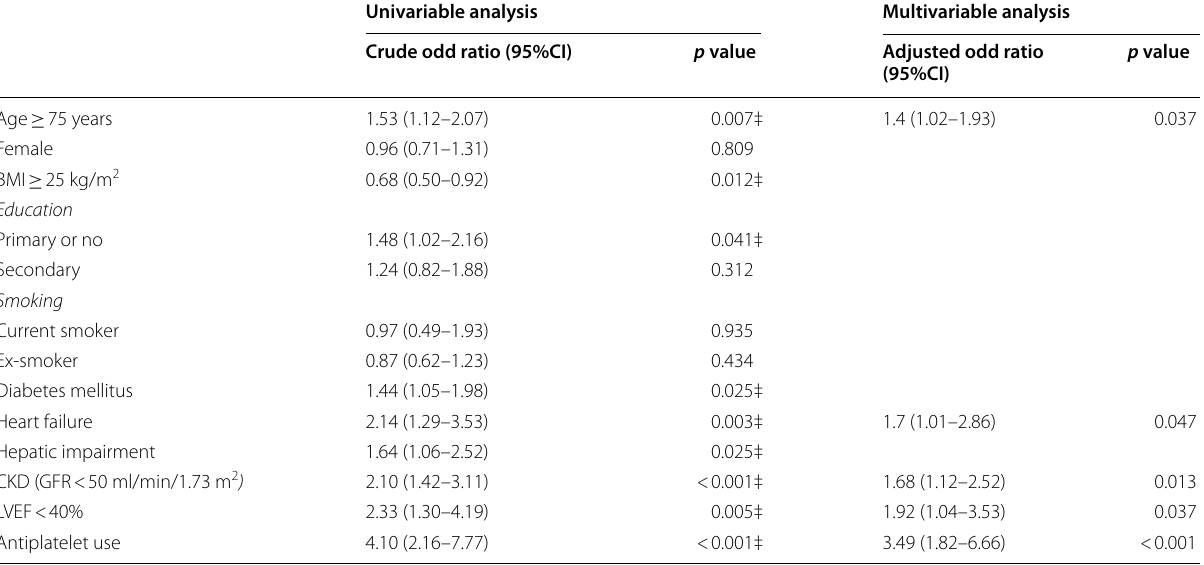
Table 2 Univariate and multivariate logistic regression analysis for predictors of poor anticoagulant control on warfarin (TTR < 65%) in NVAF